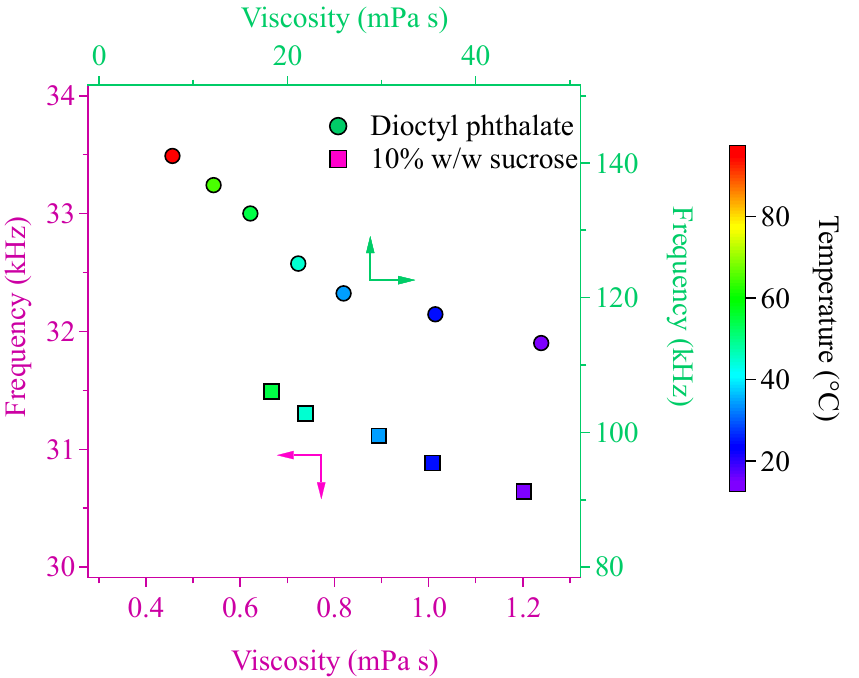
Figure 4. Resonant frequencies of the 10% w / w sucrose and dioctyl phthalate as a function of the viscosity retrieved from the hydrodynamic model. The closed symbols are the average resonance frequencies of three measurements. The shaded area is the standard deviation of the three measurements. The temperature-dependent viscosities of 10% w / w sucrose and the DOP are shown in Figure 5. The closed symbols are the viscosity values obtained from the current study. The open symbols are the viscosity values reported in the literature. In the current study, the viscosity decreased as temperature increased for the 10% w / w sucrose and the DOP. For the 10% w / w sucrose, the viscosity decreased to 55% (from 1.2 to 0.66 mPa s) as the temperature increased from 15 ◦ C to 55 ◦ C. For the DOP, the viscosity decreased to 35% (from 88.80 to 30.90 mPa s) as the temperature increased from 15 ◦ C to 55 ◦ C, and further down to 17% (15 mPa s) when the temperature reached 95 ◦ C. The viscosity values reported from this study agree with those reported in the literature (Figure 5). For example, in the study by Telis et al. [26], the viscosities of 10% w / w sucrose solution at temperatures of 15 ◦ C, 25 ◦ C, 35 ◦ C, 45 ◦ C, and 55 ◦ C were 1.41, 1.13, 0.89, 0.74, and 0.57 mPa s from the rheometer (open squares in Figure 5), while the values were 1.41, 1.13, 0.92 mPa s at temperatures of 15 ◦ C, 25 ◦ C, 35 ◦ C from the viscometer (open triangles in Figure 5). Rheometer and viscometer are traditional ways to measure the viscosity of the materials but require a large amount of the materials. Those values line within 20% difference compared to the current study. In addition, Lorenzi et al. [27] measured the viscosity of the DOP at a range of temperatures from 20 ◦ C to 122 ◦ C. In that study, the viscosity of the DOP ranged from 55.76 to 5.12 mPa s when the temperature changed from 20 ◦ C to 122 ◦ C (Figure 5, open circles). These viscosity values were in general consistent with the method